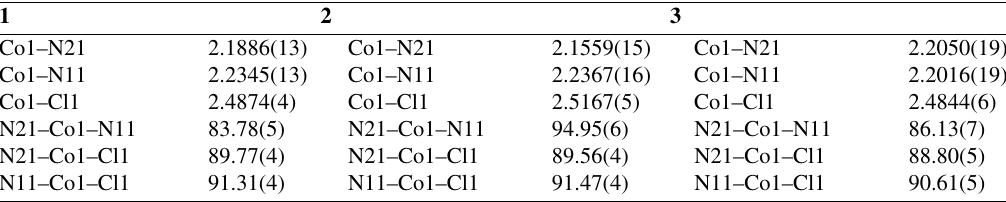
Table 2. Selected bond lengths (Å) and angles (°) for 1 , 2 and 3